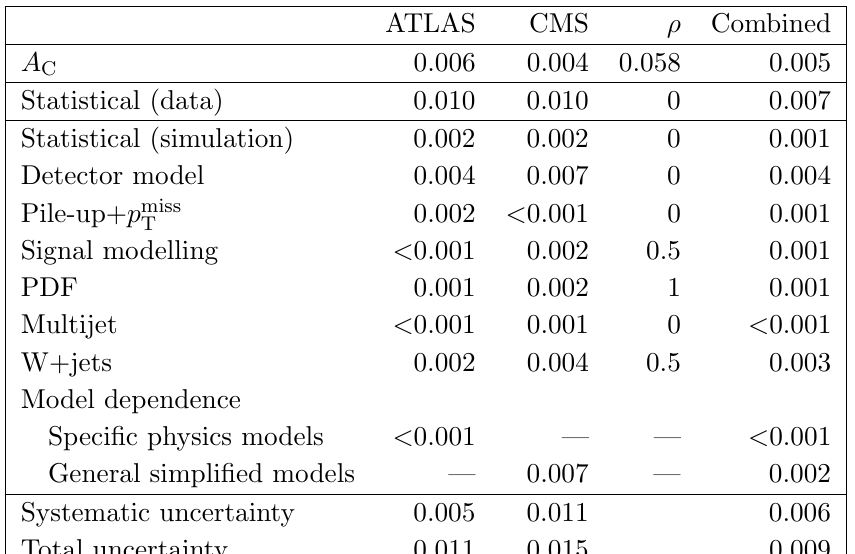
Table 2 . Uncertainties in the input measurements, assumed correlations (cid:26) between the uncertain- ties, and the resulting values for the uncertainties in the inclusive combination at Systematic uncertainties smaller than 0.001 are shown as \ < 0 : 001" in the table and are ignored in the combination.